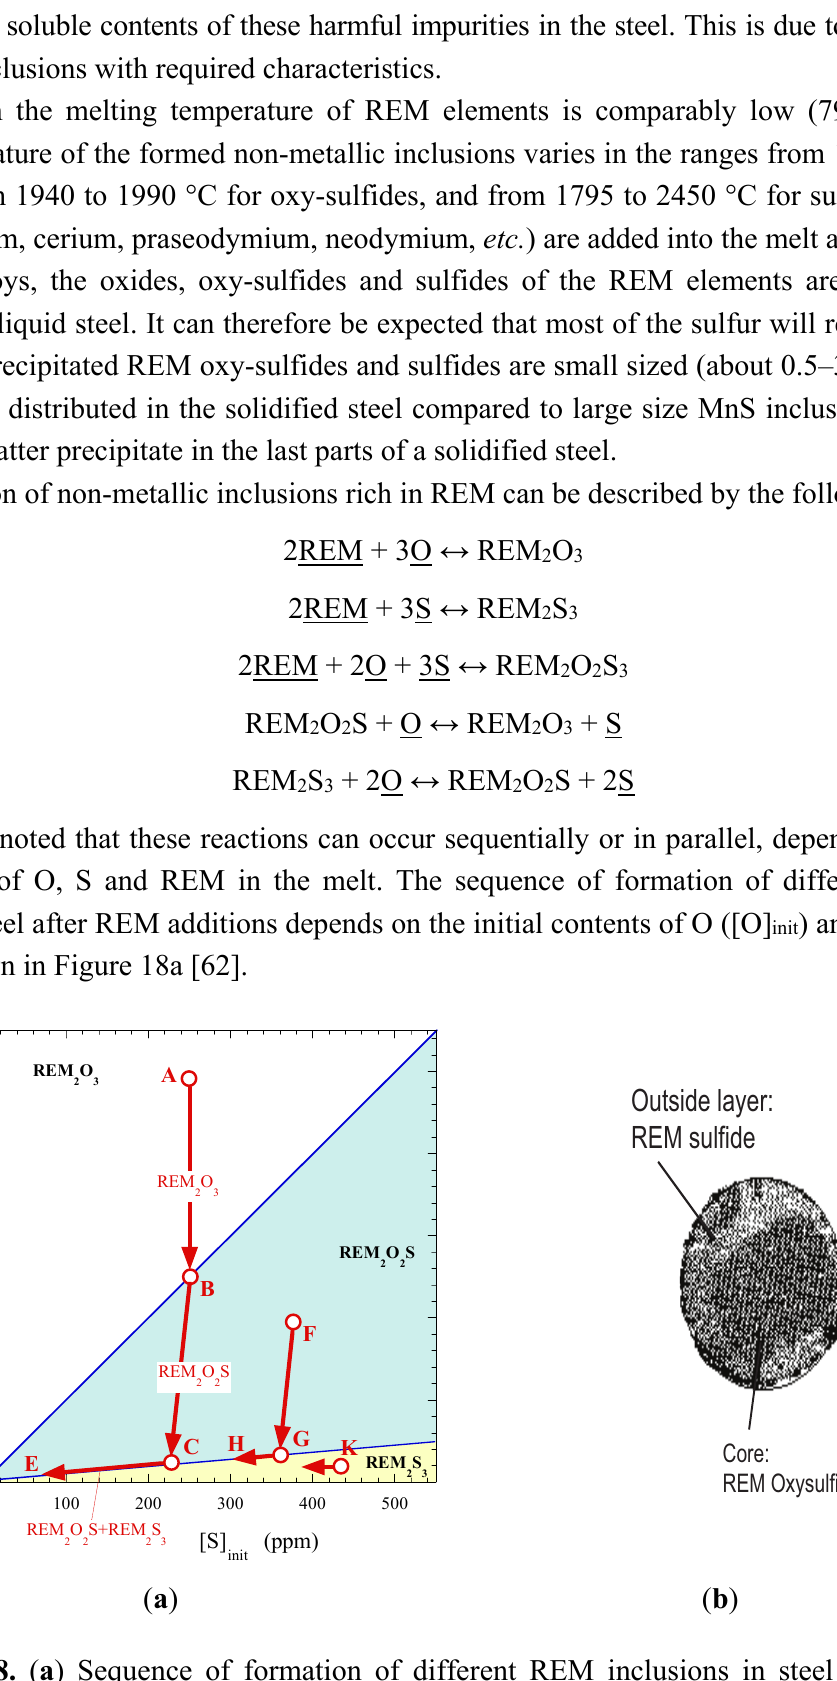
Figure 18. ( a ) Sequence of formation of different REM inclusions in steel after REM additions in relation to the initial contents of O and S [62]; ( b ) Typical complex REM inclusion in steel with 0.02% REM